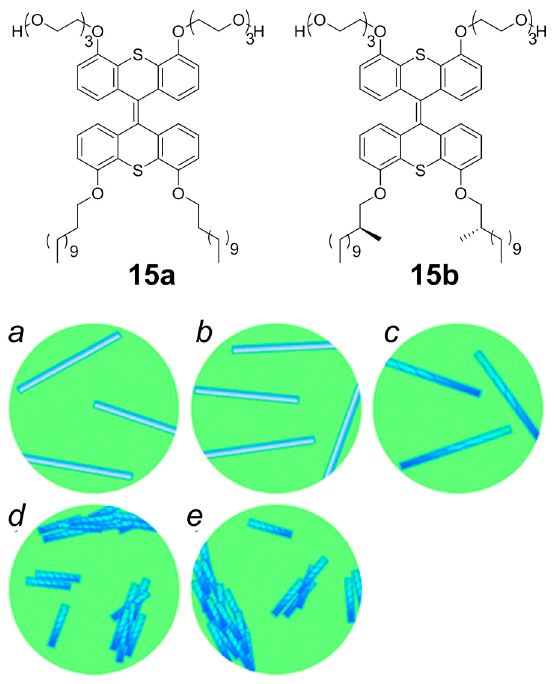
Figure 12. Top: Structure of amphiphile 15a and 15b . Bottom: Schematic model for the observed behavior of NTs consisting of 15a and 15b as a function of the amount of 15b : ( a ) pure 15a ; long, isolated achiral nanotubes; ( b ) <25% 15b ; long, isolated achiral nanotubes; ( c ) 25–50% 15b ; long, isolated chiral nanotubes; ( d ) >50% 15b ; short, bundled chiral nanotubes; and ( e ) pure 15b ; short, bundled chiral nanotubes. Partially reproduced with permission from Ref. [53] (Copyright Royal Society of Chemistry, 2017).